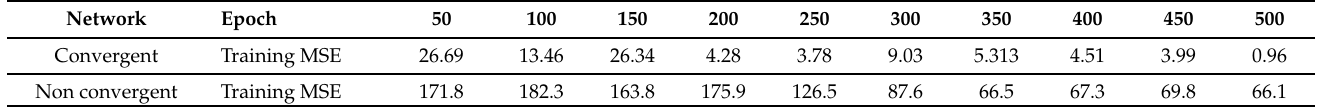
Table 5. Loss of SOC estimation in different epoch.